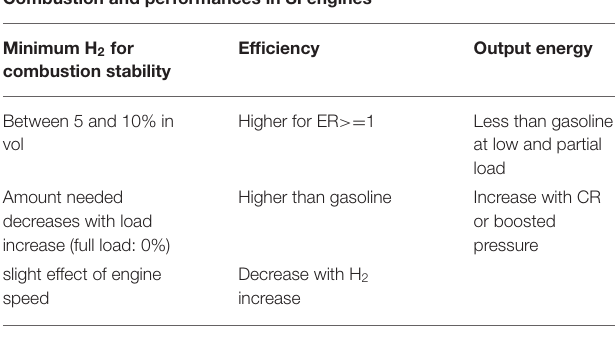
TABLE 2 | Summary of main tendencies for Ammonia/H 2 in SI engines: performances and